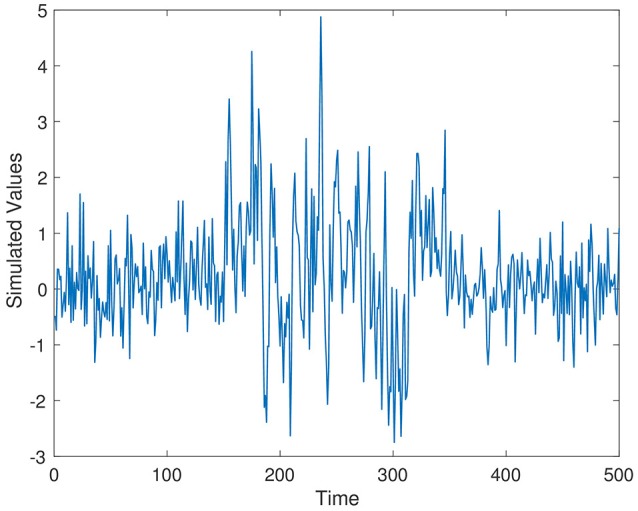
Simulation time series 1, ρ1 = 0.7.